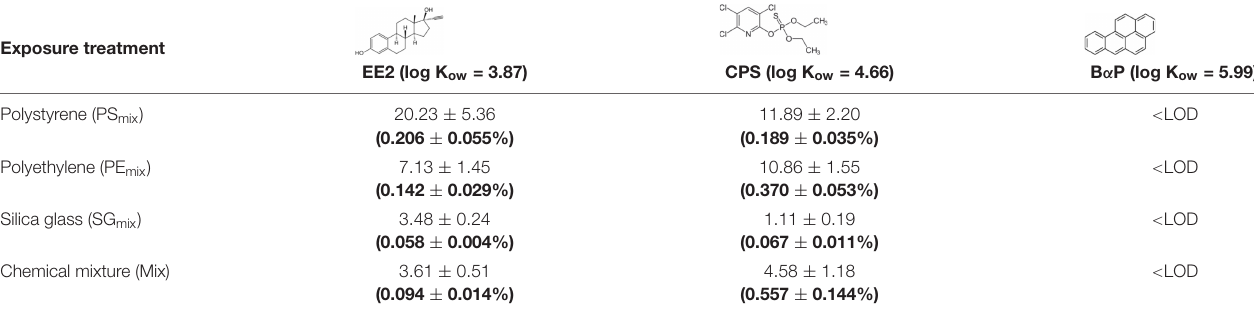
TABLE 1 | Accumulation of model HOCs compounds in fish muscle, expressed by average amount chemical (ng) per g fish in the end of the experiment ±